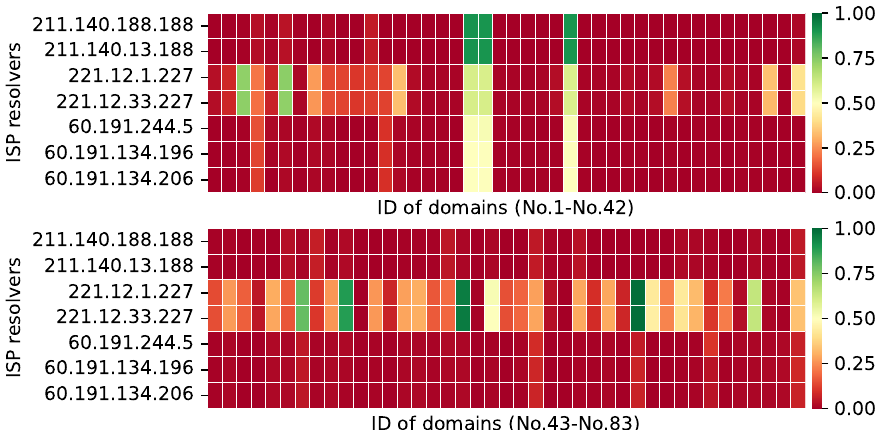
Figure 10. The correct response rate of resolvers belonging to the same ISP is basically the same. Correct responses are only loosely related to time. To determine whether the rate of correct responses by DNS resolvers to domain name requests is time-dependent, as illustrated in Figure 11, we take hourly intervals and calculate the average accurate rate of DNS resolvers responding to each domain name throughout this time period. The average number of requests per domain name per hour is approximately 120, which means that the IP addresses for domain names are requested twice every minute from a single